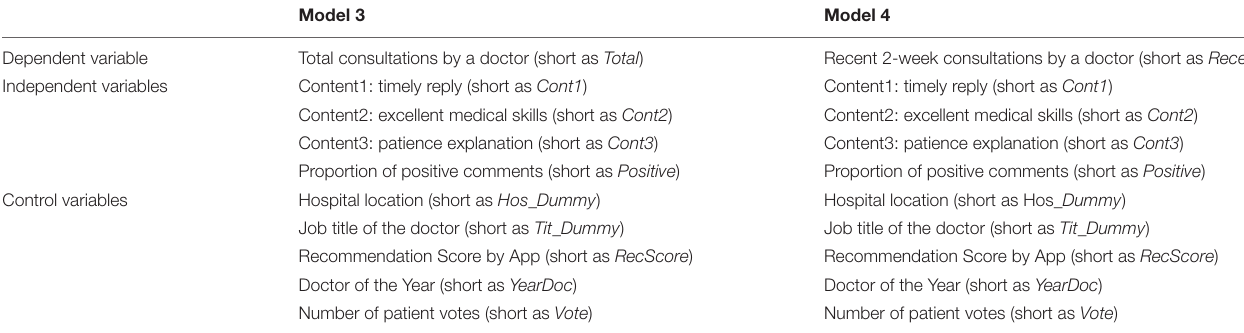
TABLE 9 | The explanation of econometric model 3 and model 4. Model 3 Model